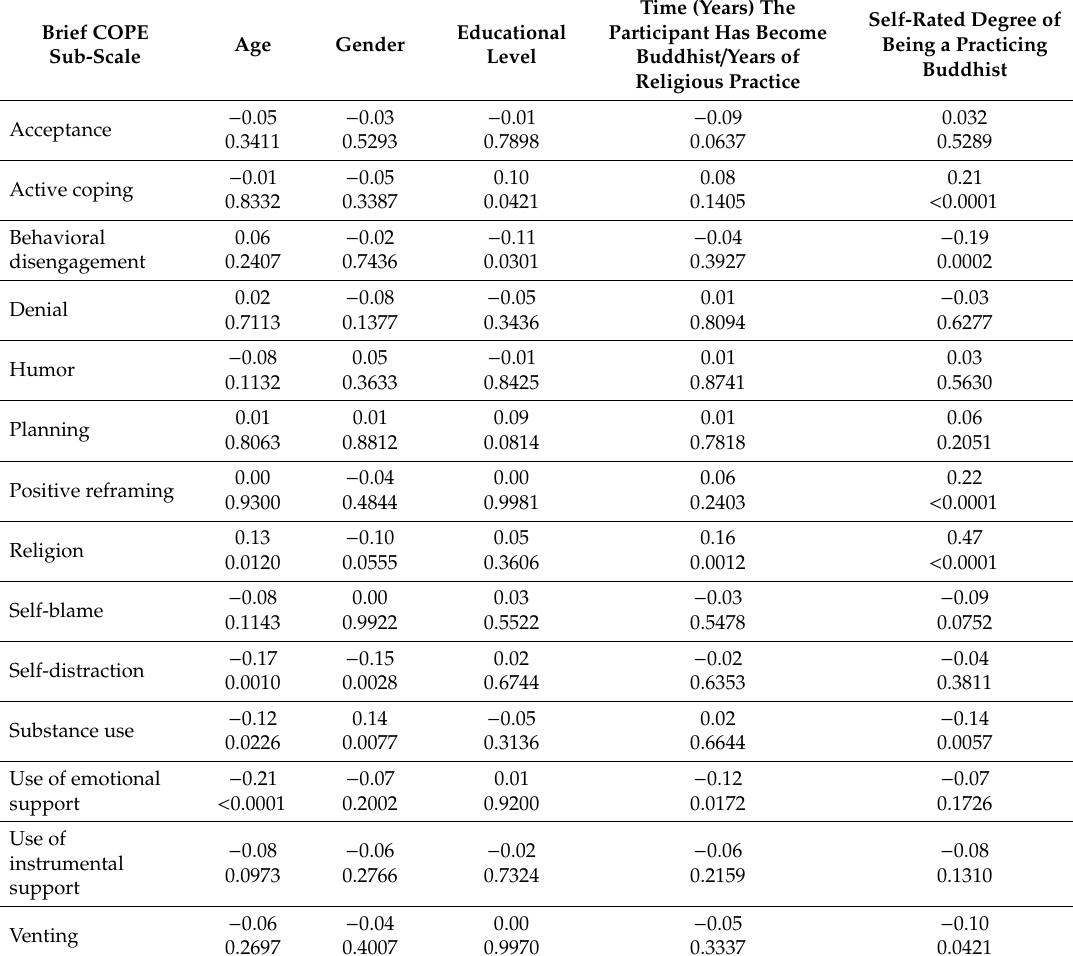
Table 2. Correlations between the Brief COPE questionnaire scores, time (years) the participant has become Buddhist / years of religious practice and the self-evaluated grade of being a practicing Buddhist. The first value represents the correlation coe ffi cient, the second value the p -value (statistical